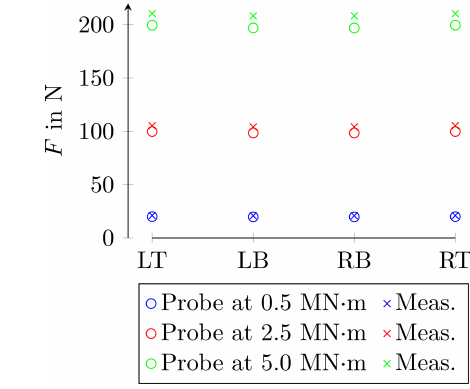
Figure 10. FE validation for the FT measurement.